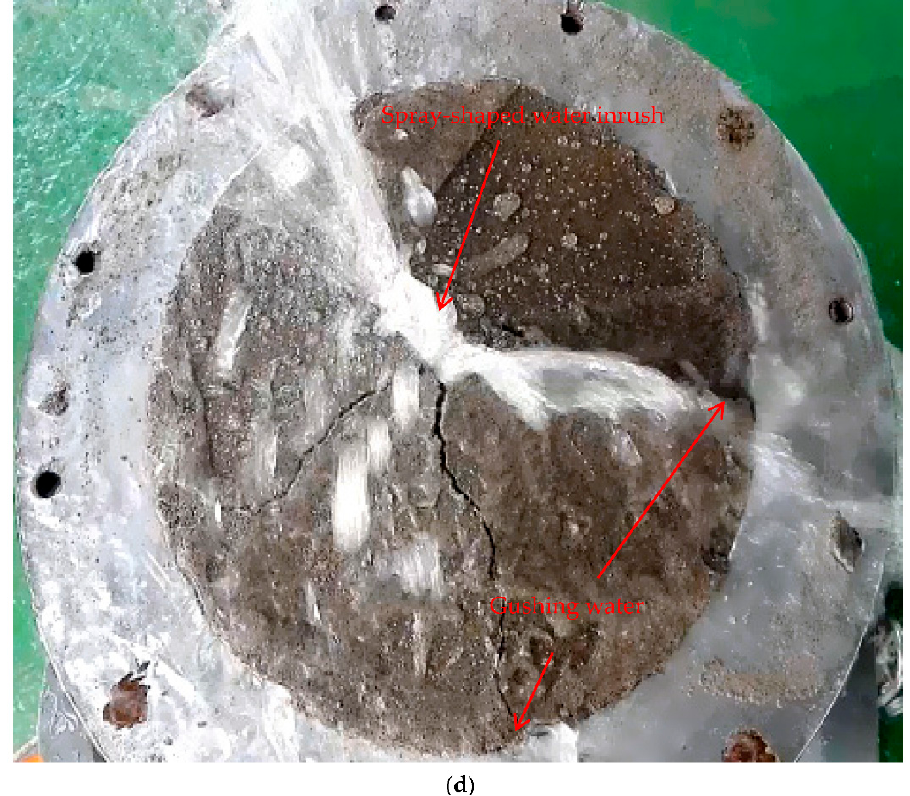
Figure 10. Water inrush stage at the bottom of arch. ( a ) White bubble appeared in the middle of the aquifuge rock. ( b ) The crack extension. ( c ) Cross-shaped cross crack and uplift of aquifuge rock. ( d ) Water inrush occurred.